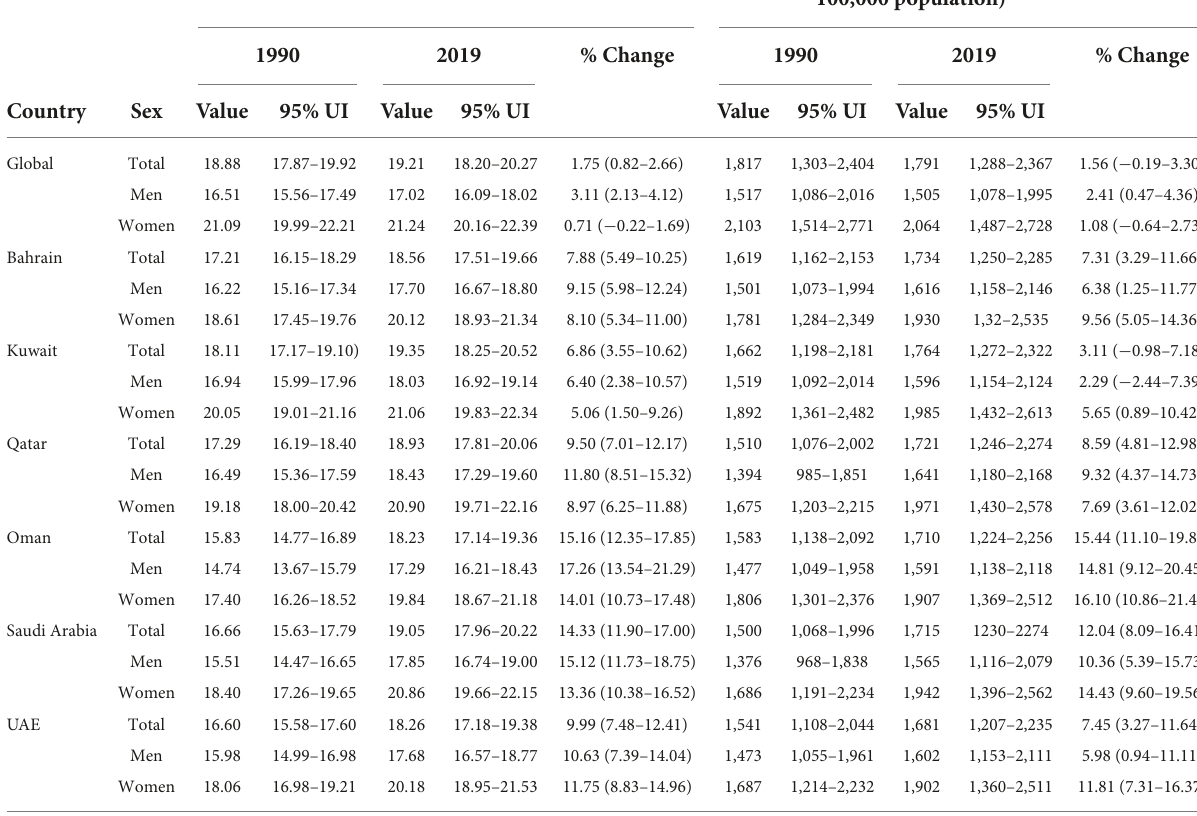
TABLE 2 Age-standardized prevalence (%) and YLDs (rates per 100,000 population) of MSK disorders in 1990 and 2019, and the corresponding percentage change between 1990 and 2019, in GCC